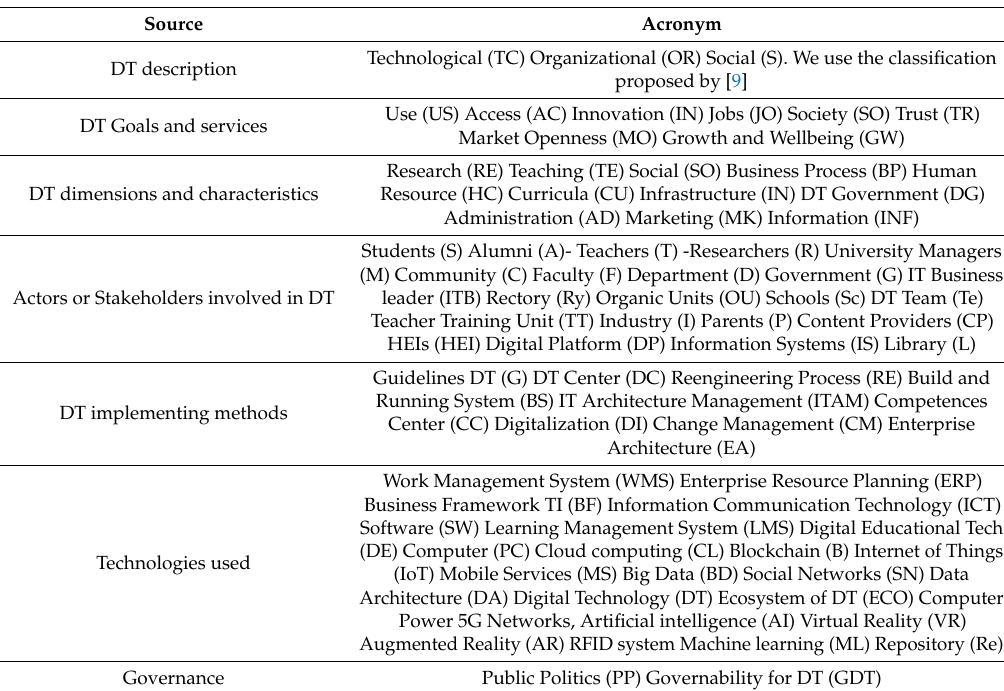
Table 2. Acronyms to classify